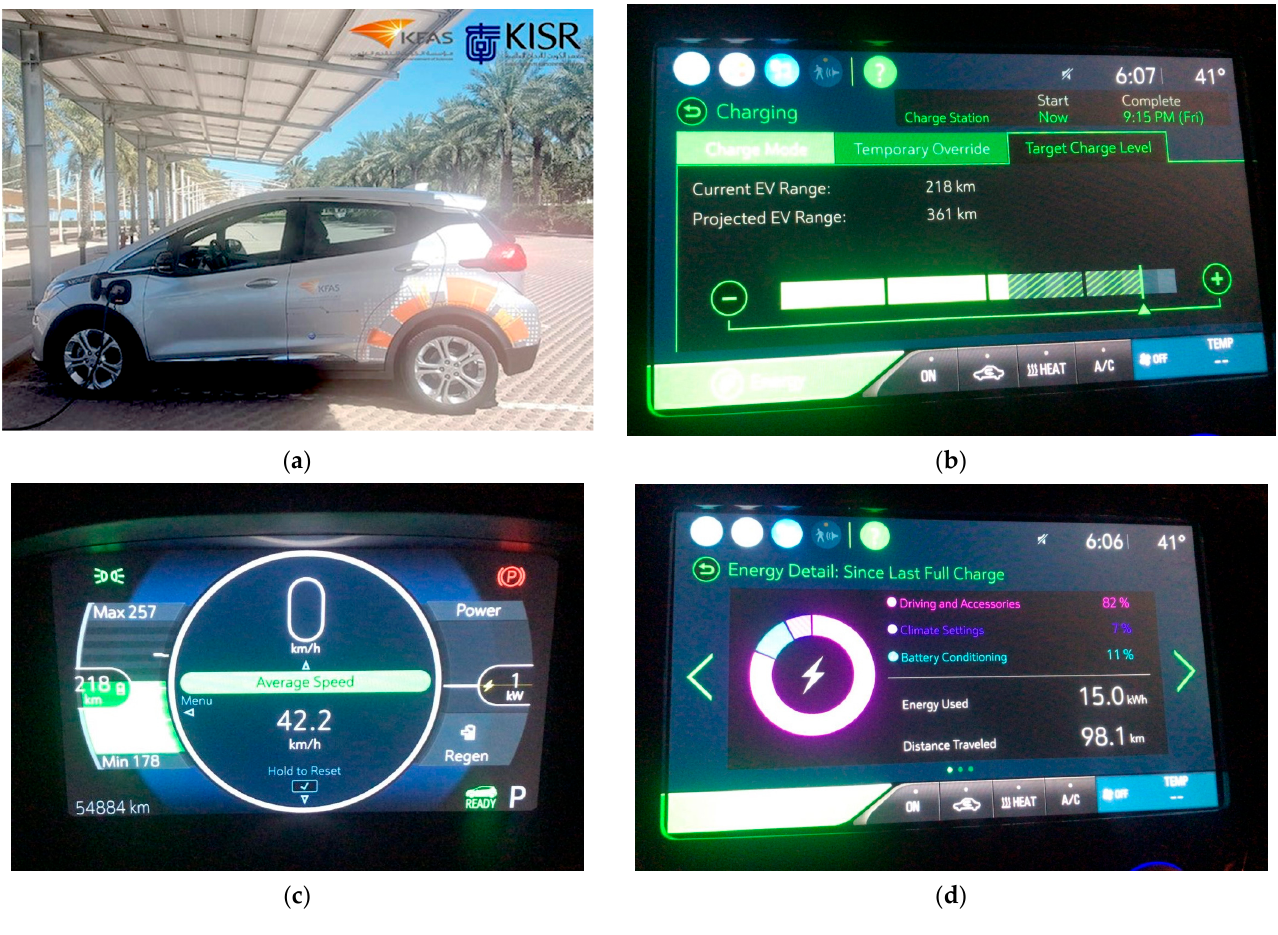
Figure 1. ( a ) Photograph of the test vehicle. ( b – d ) Vehicle status display showing information collected at beginning and end of each journey. Table 2. The 2019 Chevrolet Bolt EV specifications.